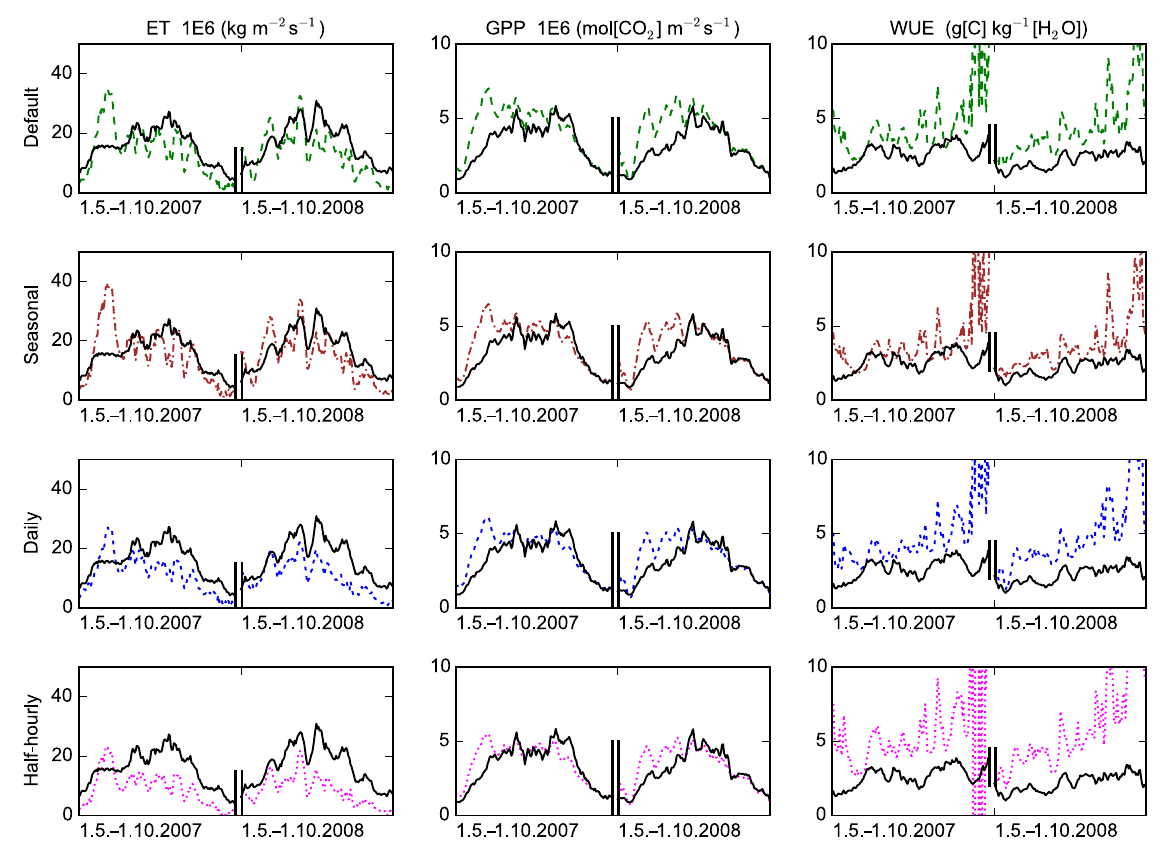
Figure 3. Sodankylä 7-day-running mean time series for different tunings for the last two summers of the validation period. Solid black line represents the